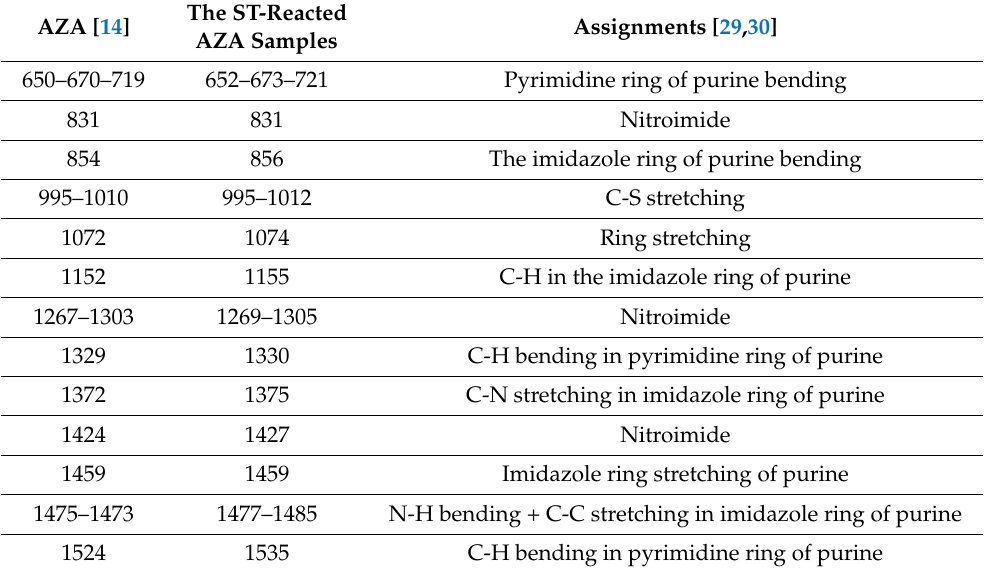
with ST concentrations in the reaction mixture of 25 wt.%, 50 wt.% and 75 wt.% (cm − 1